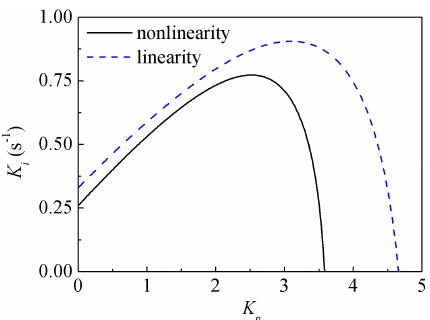
Figure 7. Comparison of the stable domains of the hydro-turbine governing system considering the saturation nonlinearity of the governor or not [60].